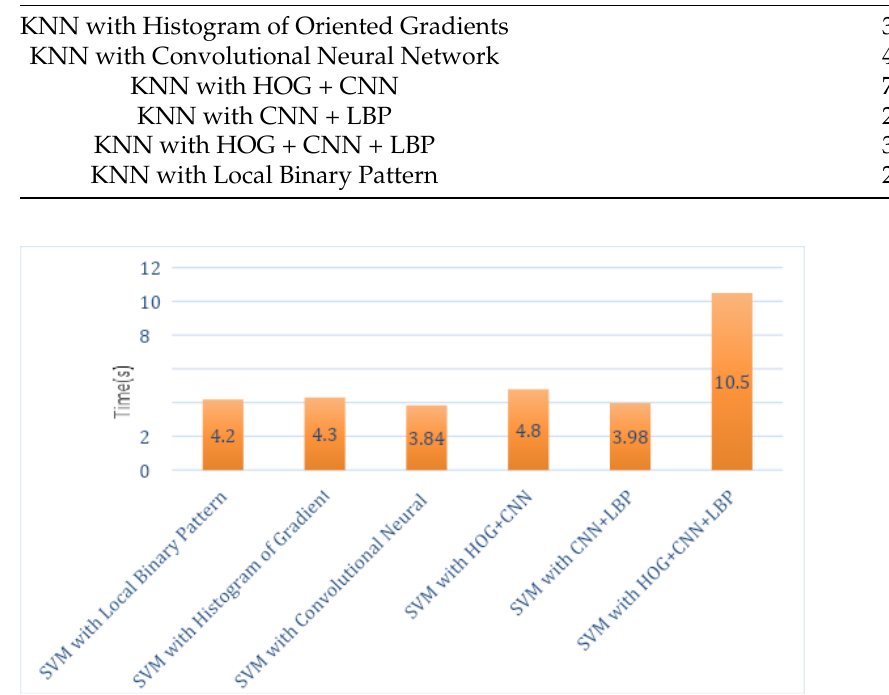
Figure 5. Execution Time Analysis of SVM